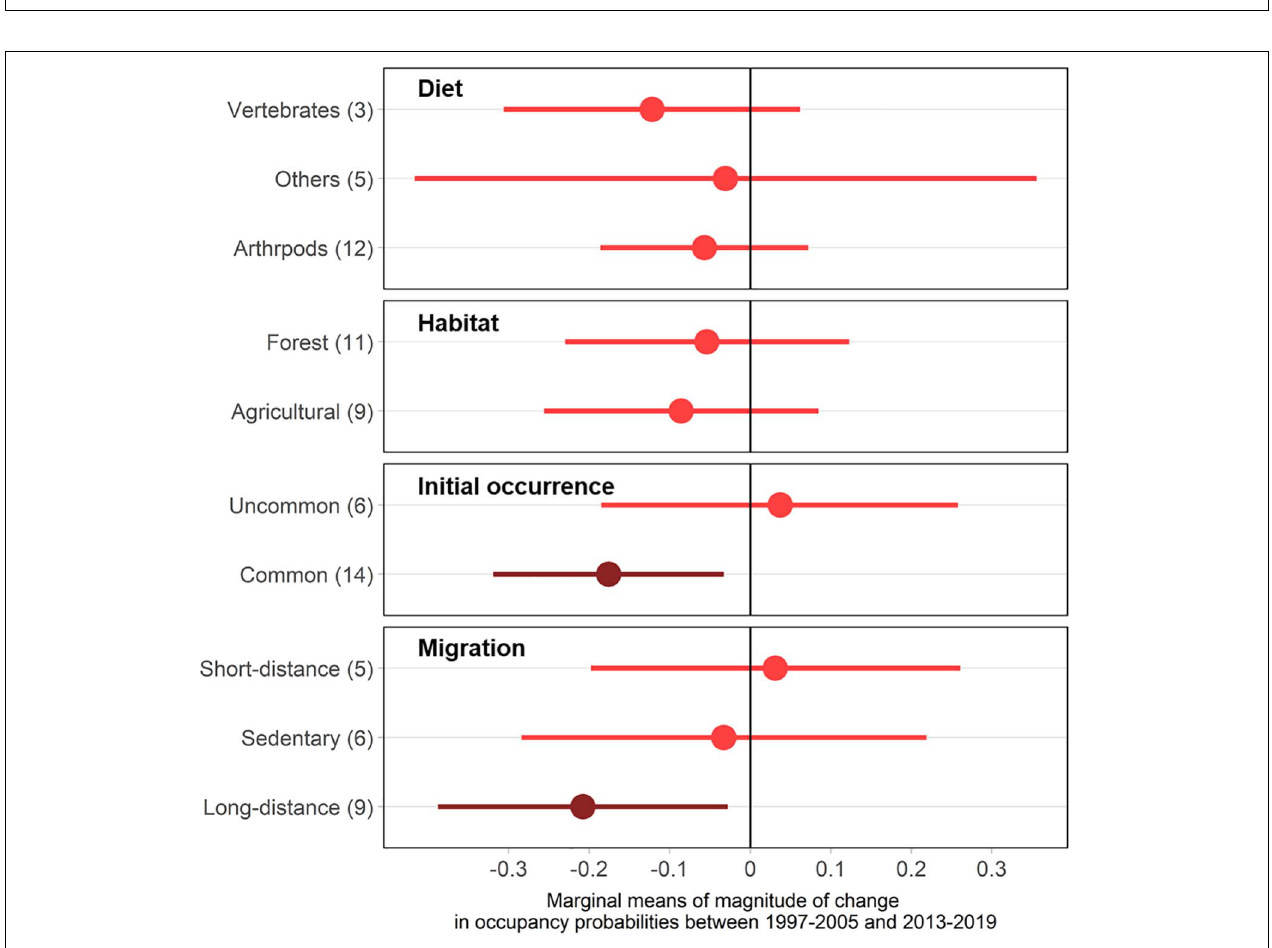
FIGURE 4 | Each trait group’s marginal means and confidence intervals (Tukey-adjusted significance level) for the difference in occupancy between 1997–2005 and 2013–2019 ( (cid:49) ψ = ψ t = 2 − ψ t = 1 ) in declining species (20 species) in this study. Numbers in the y -axis label indicate the number of species per each group.